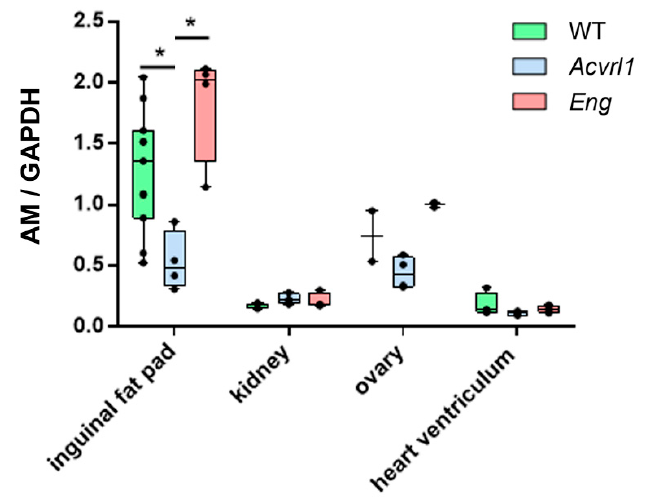
Figure 5. AM expression in mesoderm-derived organs as measured by qRT-PCR. Box plots represent the interquartile range with the median as a horizontal line. Whiskers encompass the maximum and minimum values of the population. Dots represent individual animals. *: p < 0.05.